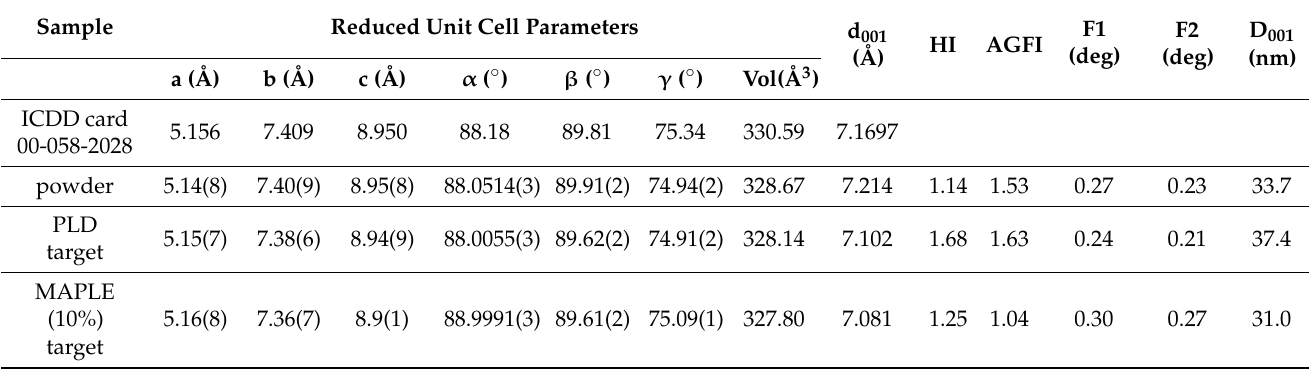
Table 2. Structural data of the commercial powder and the targets obtained from XRD analysis.